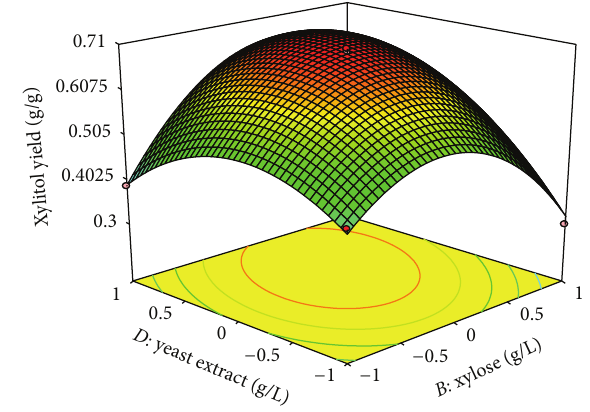
Figure 3: 3D plot showing the effect of xylose and yeast extract on xylitol yield.